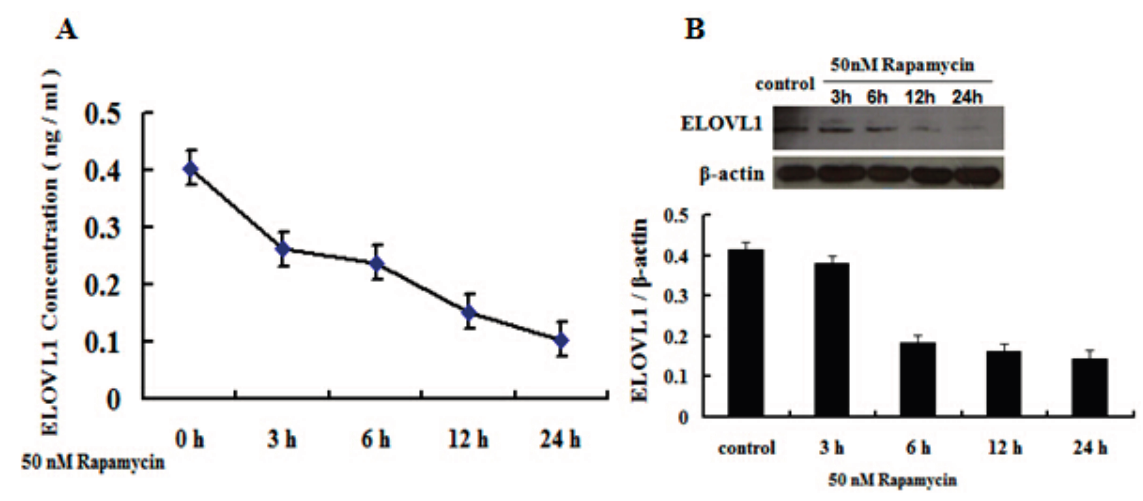
Figure 6. Rapamycin induces a time-dependent decrease in the expression of ELOVL1. Cells were treated with 50 nM rapamycin for 3, 6, 12 and 24 h, and ELOVL1 in cells was detected by ELISA ( A ) and Western blot ( B